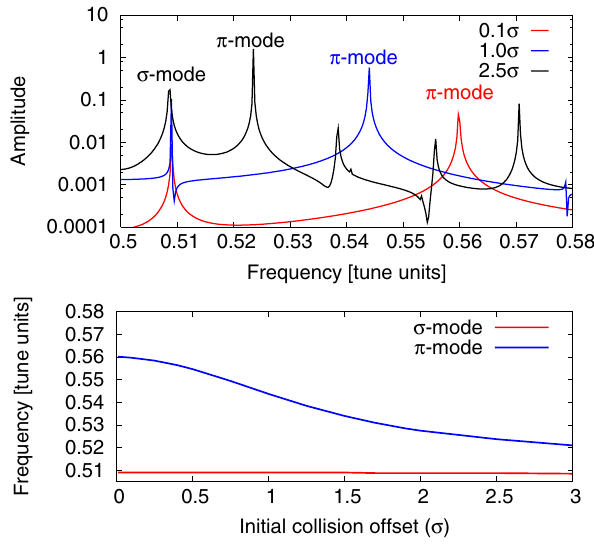
FIG. 11. Illustration of the dependence of beam-beam eigen- modes on the beam oscillation amplitude using a rigid bunch model. Top: horizontal spectrum for three cases with increasing initial collision offset showing a reduction of the (cid:4) -mode frequency. Other spectral lines generated by the nonlinearity of the beam-beam interaction are observed for the 2 : 5 (cid:5) and 1 : 0 (cid:5) cases. Bottom: (cid:4) - and (cid:5) -mode frequencies versus initial collision offset.